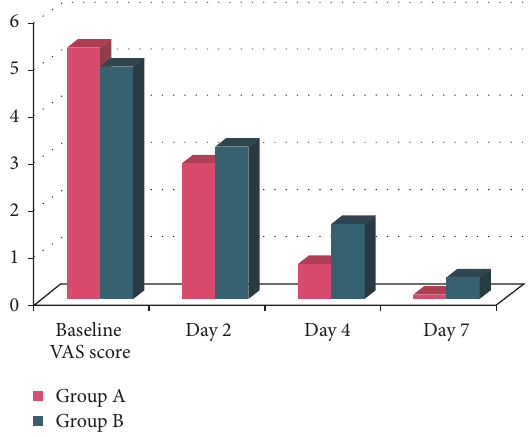
Figure 1: Intergroup comparison of VAS score for pain assessment.